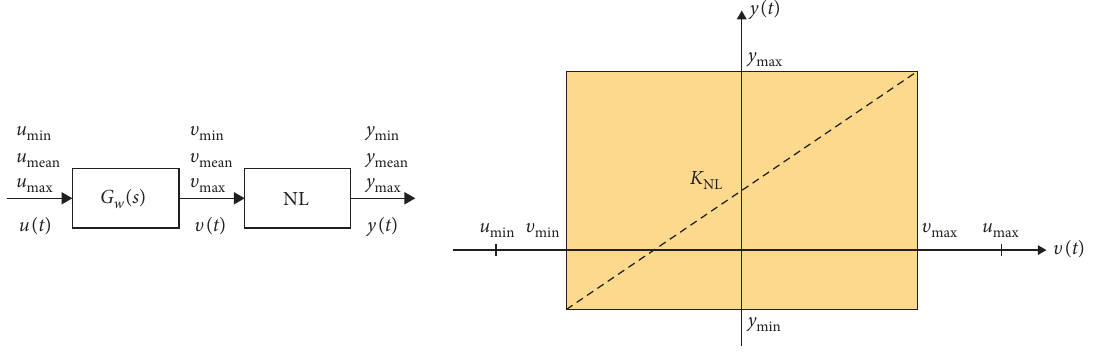
Figure 3: Search space for nonlinear static function in a Wiener model.